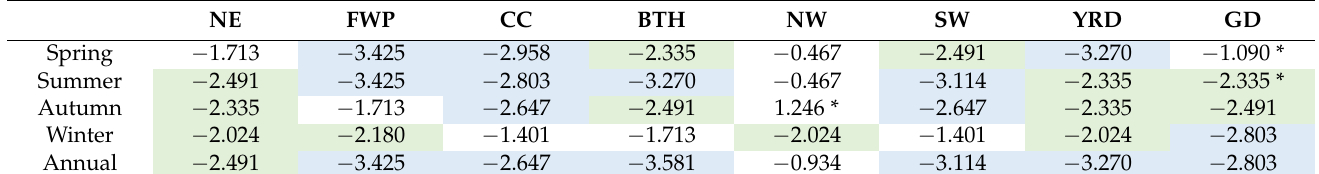
Table 2. Temporal trends in the AOD for the eight major regions detected by the M–K test and Hurst index.